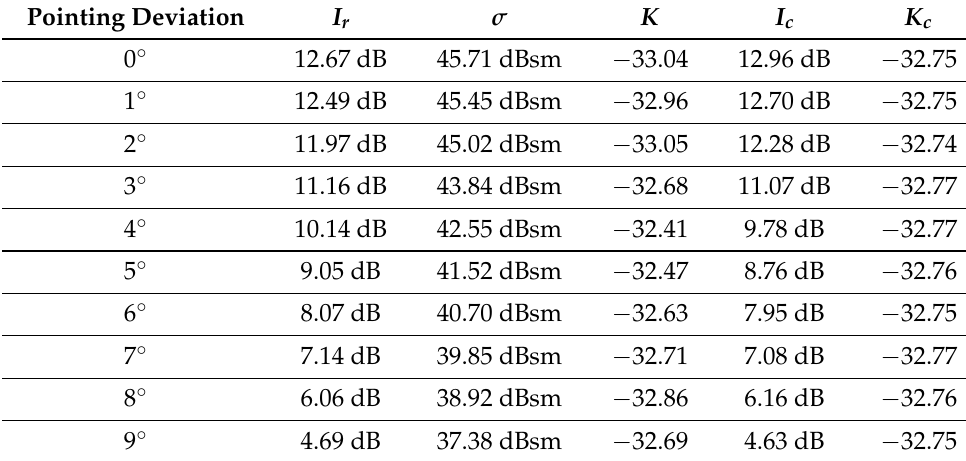
Table 4. The calibration results after error